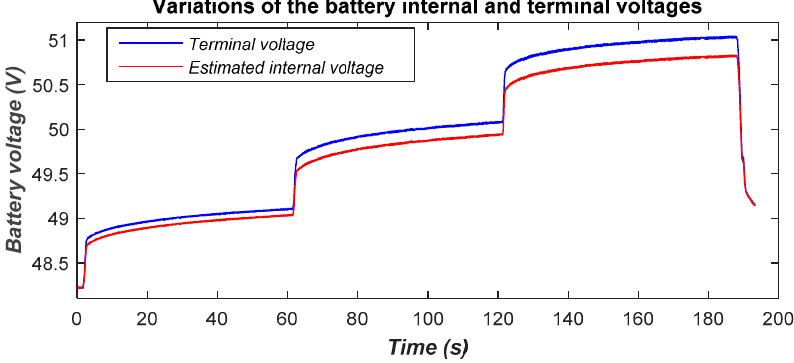
Figure 27. Battery terminal and internal voltages.